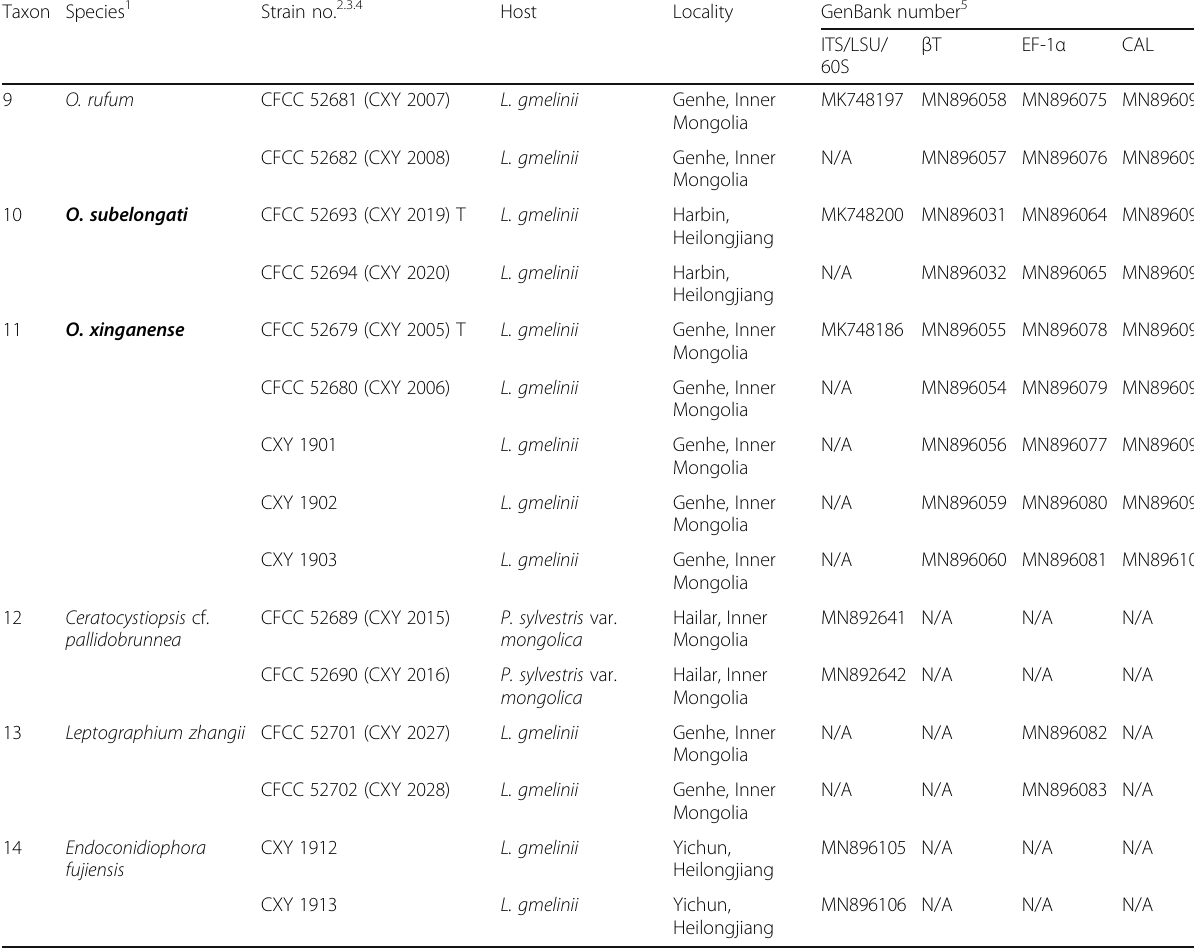
Table. 1 Strains of ophiostomatoid fungi sequenced and used for morphological and phylogenetic analysis in this study (Continued) Taxon Species